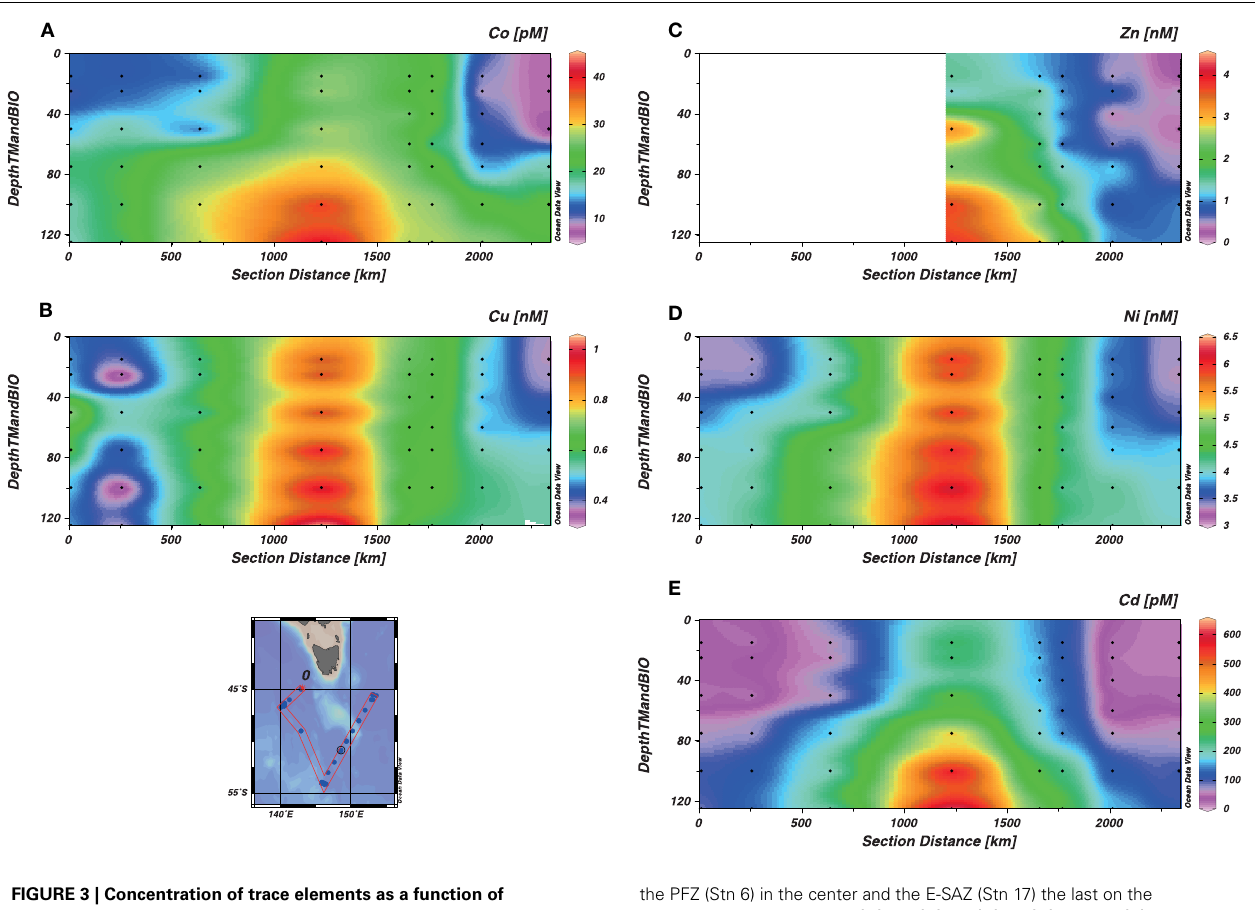
FIGURE 3 | Concentration of trace elements as a function of depth. The section represents the whole voyage track from Stn 2 to Stn 17, with theW-SAZ (Stn 4) being the second station on the left,